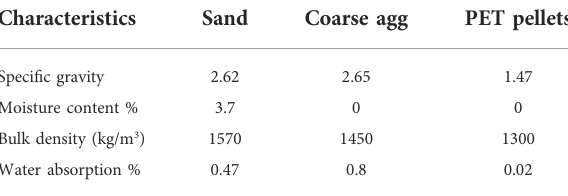
TABLE 3 Physical Characteristics of fi ne and coarse